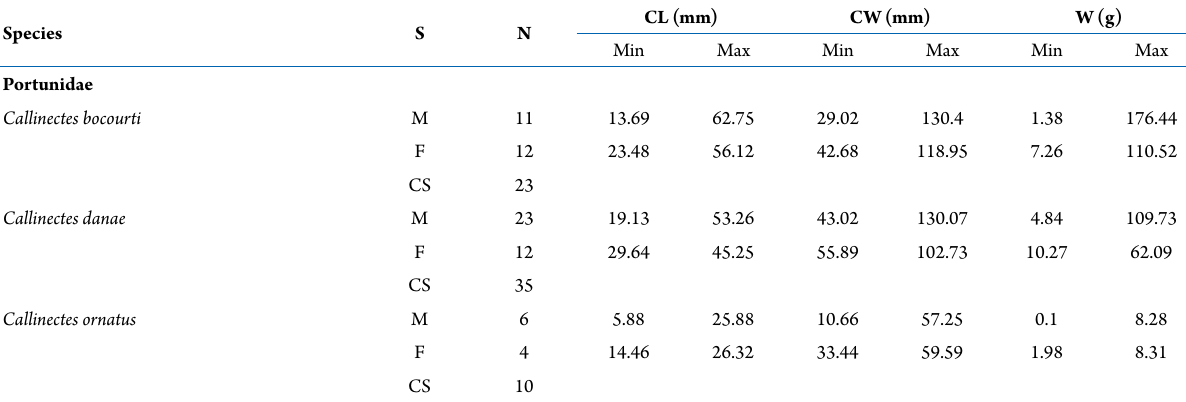
Table 1. Sample size (N) and ranges of carapace length (CL), carapace width (CW), and weight (W) for male, female and combined sexes of Callinectes bocourti A. Milne-Edwards, 1879, Callinectes danae Smith, 1869 and Callinectes ornatus Ordway, 1863 from northern